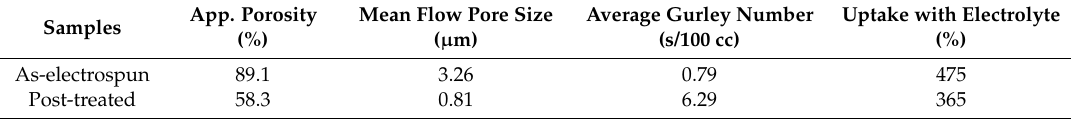
Table 3. Textural properties of as-electrospun and post-treated PEI/PVdF_40min